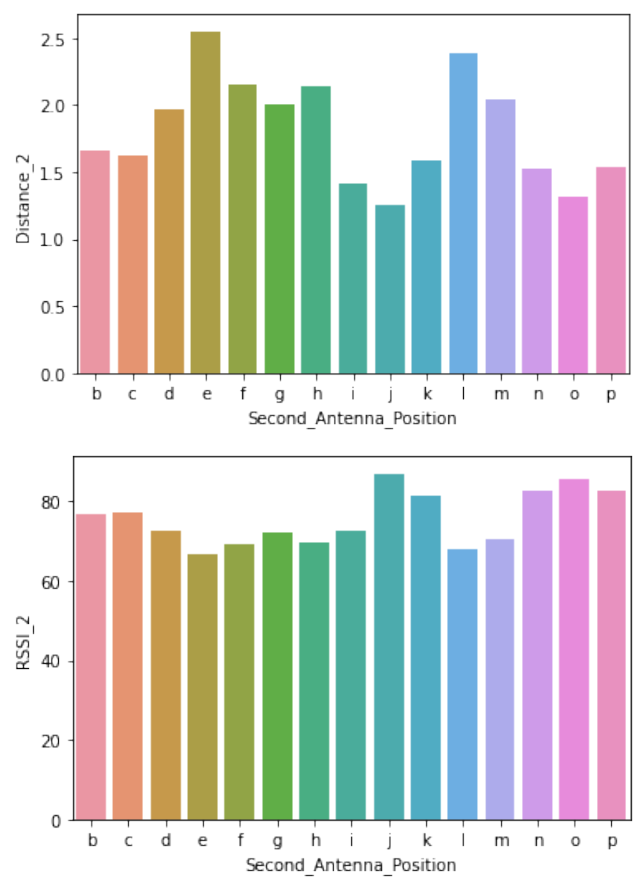
Figure 4. Second Antenna position distance and Received Signal Strength Indicator (RSSI), where the top is reader–antenna position and its distance from tag, and the bottom is reader–antenna position and